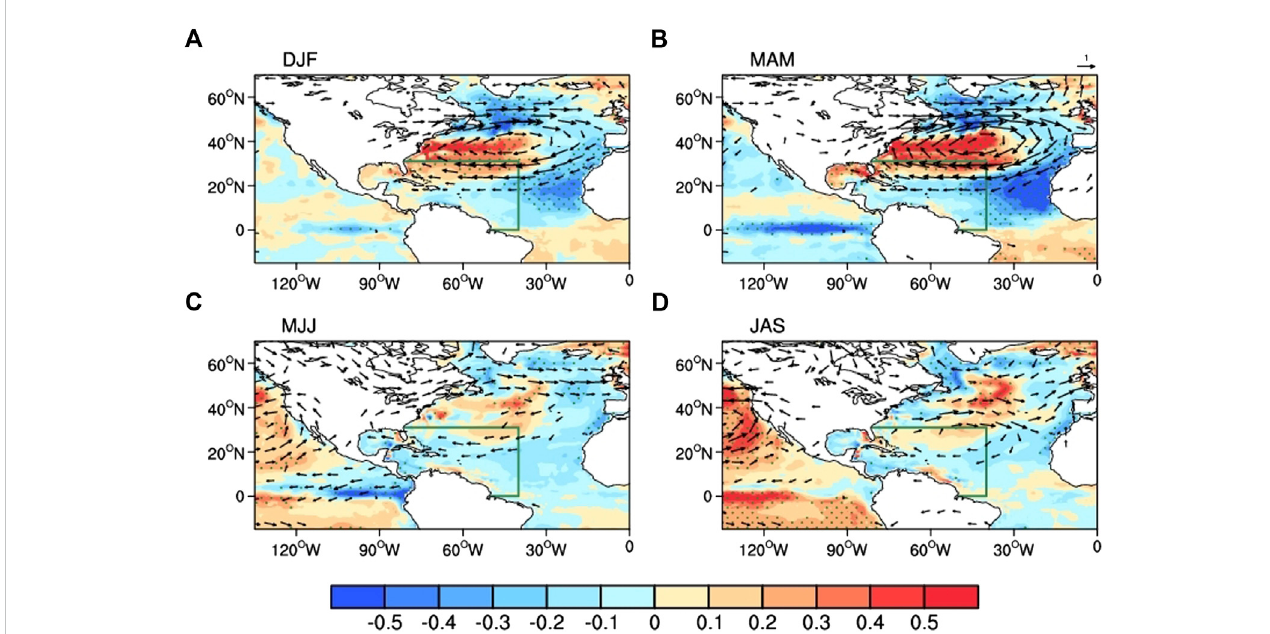
FIGURE 8 CompositedifferencesintheseasonalevolutionofSST(shading,units: ° C)andsurfacewind(vectors,units:m\s)anomaliesbetweentheassimilationand controlexperimentsfor (A) DJF, (B) MAM, (C) MJJand (D) JAS.Positive(red)andnegative(blue)SSTanomalieswithsigni fi cantatorabovethe90%con fi dence level are stippled. Only surface wind vectors signi fi cant at the 90% con fi dence level are shown. The green box area indicates the extent of the